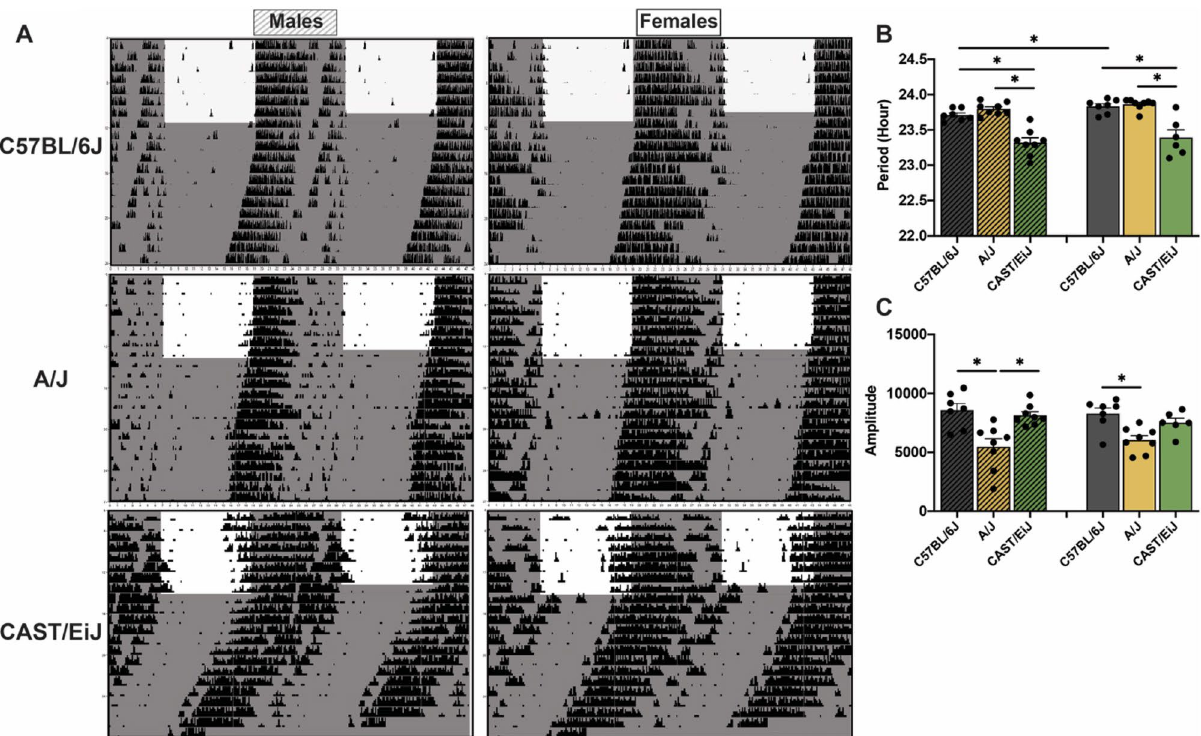
Figure 4. Circadian rhythms of wheel-running activity in two extreme founder strains along with C57BL/6J strain. (A) Representative actograms of wheel-running activity in C57BL/6J, A/J and CAST/EiJ mice that were maintained under 12:12 light–dark cycles for entrainment and then released to constant darkness for free- run. (B) The period and (C) amplitude of the activity rhythms during constant darkness were quantified by periodogram analysis. Shade indicates light-off. Bar graphs depict mean ± SEM. Bar graphs with fill pattern indicate the data from males. Asterisks indicate significant differences (p <